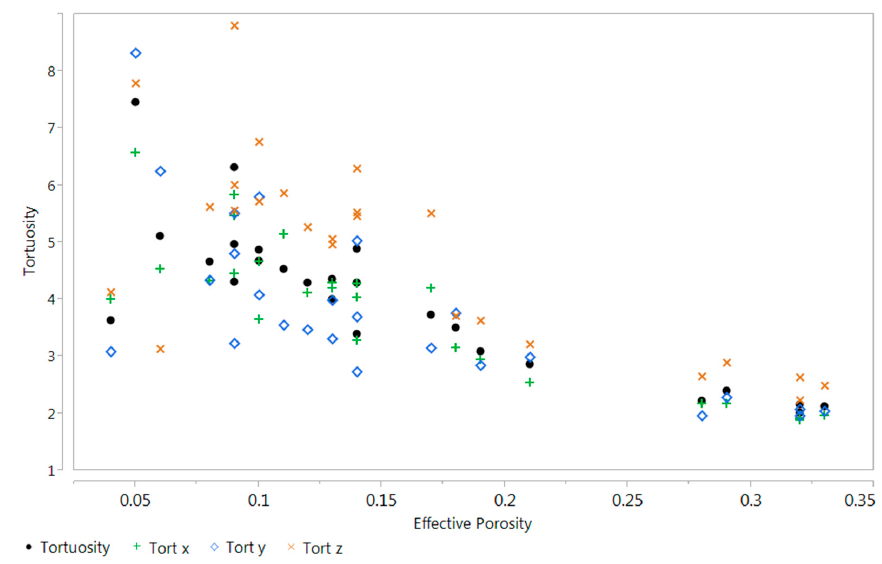
Figure 8. Scatter plot between effective porosity and tortuosity.